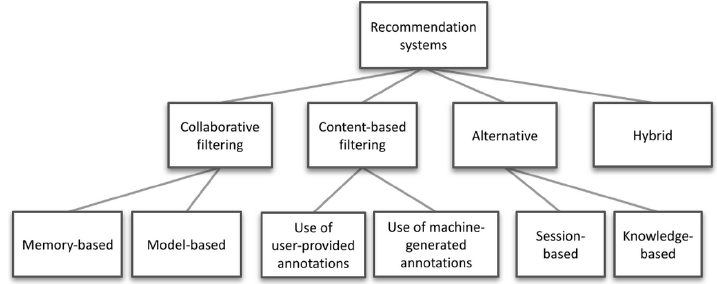
Figure 2. A taxonomy of recommendation